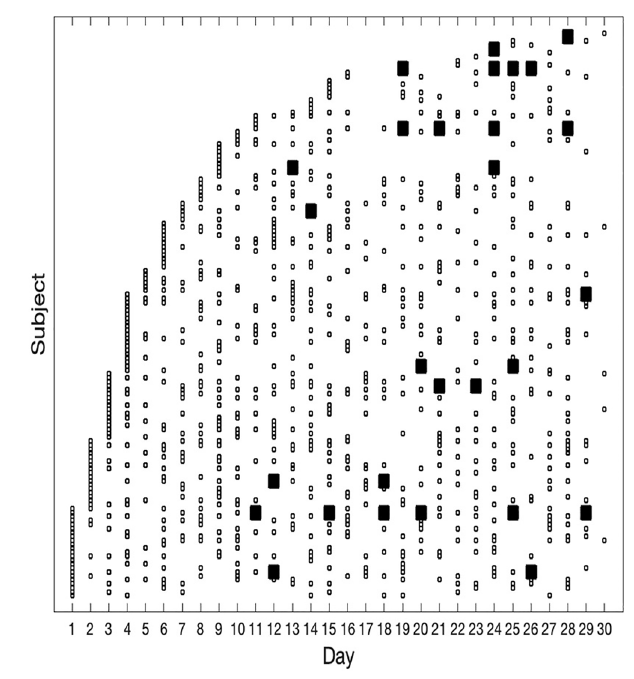
Figure 1. Daily tests and IgG positivity (via Antibody Fast Detection Kit (Colloidal Gold) Superbio, Timisoara, Romania) by subject, ordered by date of subject entry. Vertical axis: subjects ordered from earliest entry (bottom) to latest entry (top). Horizontal axis: day of the study. Small squares: negative IgG test. Large squares: positive IgG